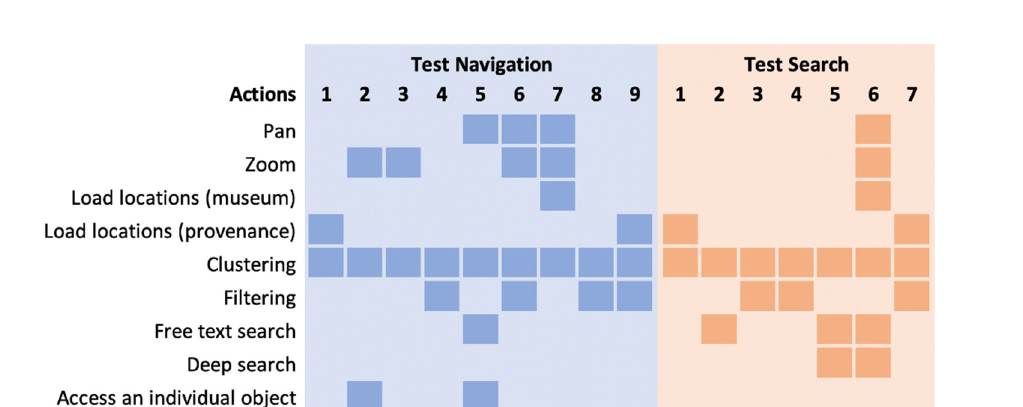
Figure 9. Graphical representation of the actions taken on the map at each step for both Test Navigation and Test Search.